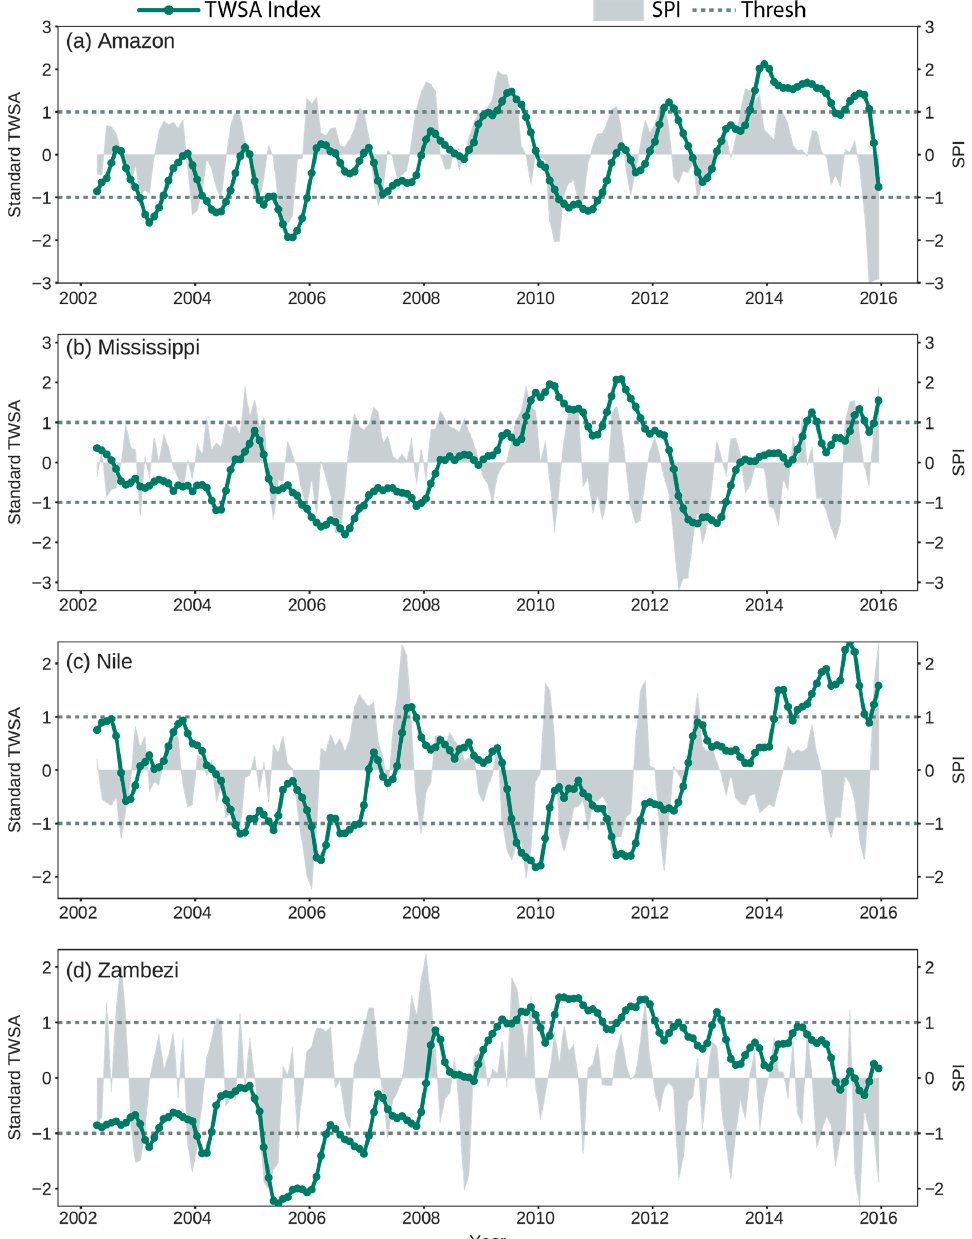
Figure 5. Standardized TWSA derived using TWSA climatology for ( a ) Amazon, ( b ) Mississippi, ( c ) Nile, and ( d ) Zambezi river basins. Left axis: standardized TWSA smoothed using 3-month moving average (dark green line with filled dots); right axis: SPI (filled gray areas) and ±1 thresholds (horizontal dotted lines). TWSA anomalous events were extracted using the ±1 thresholds.